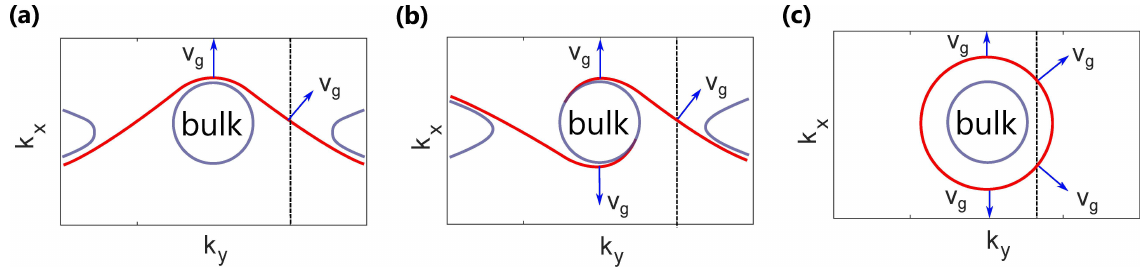
Figure 10. Bulk- and surface- mode equifrequency contours for different classes of materials at an interface with vacuum: ( a ) typical magnetized plasma (reproduced from Figure 6f), ( b ) typical chiral reciprocal plasma, and ( c ) reciprocal, non-chiral, isotropic plasma. The surface states and bulk states are indicated in red and blue color respectively, and the group velocity vectors are indicated with blue arrows. Since the chiral plasma preserves reciprocity, the equifrequency contour obeys the symmetry condition ω ( k ) = ω ( − k ) . Thus, if a surface mode in case ( b ) is propagating in the x direction, it can reflect backwards in the presence of defects, but not in case ( a ), as indicated by the group velocity arrows in the two panels. However, the surface mode in ( b ) is robust against certain defects that preserve k y , leading to no backscattering within a range of values for k y . As an example, the dashed line in ( b ) shows that, if a certain value of k y is preserved, no backward-propagating mode can be excited with the same k y . This is in contrast with the surface plasmon-polaritons on a reciprocal isotropic plasma ( c ) which can backscatter in the presence of generic defects.